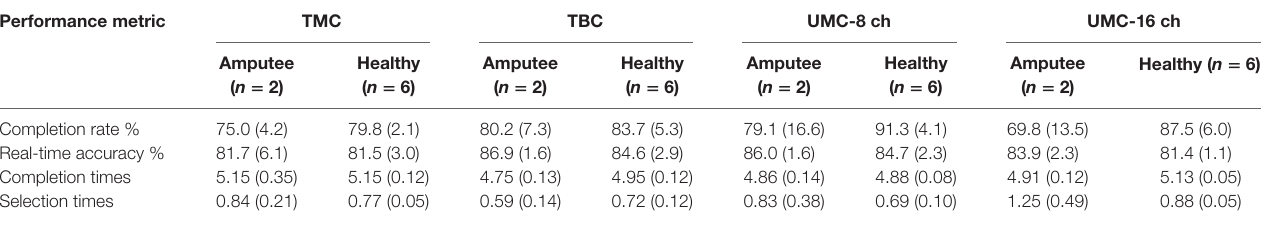
TaBle 1 | Performance metric mean values (SE) for each configuration: targeted monopolar configuration (TMC), targeted bipolar configuration (TBC), untargeted monopolar configuration with 8 channels (UMC-8 ch), and untargeted monopolar configuration with 16 channels (UMC-16 ch). Performance metric